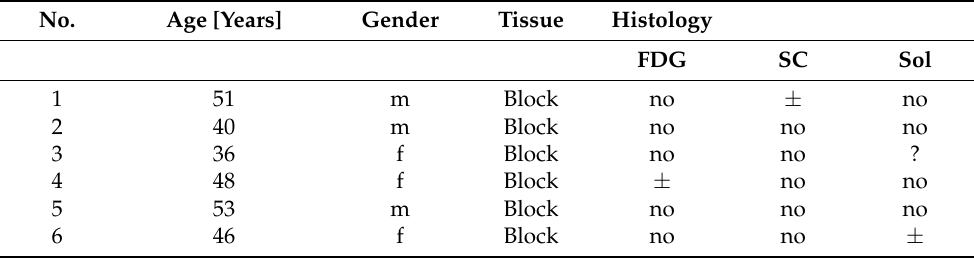
Table 1. Demographic data of control gallbladder tissue (C-GB). Age [years] at the time of chirurgical removal. FDG: signs of fatty degeneration, SC: signs of cholestasis and SoI: signs of inflammation. No.